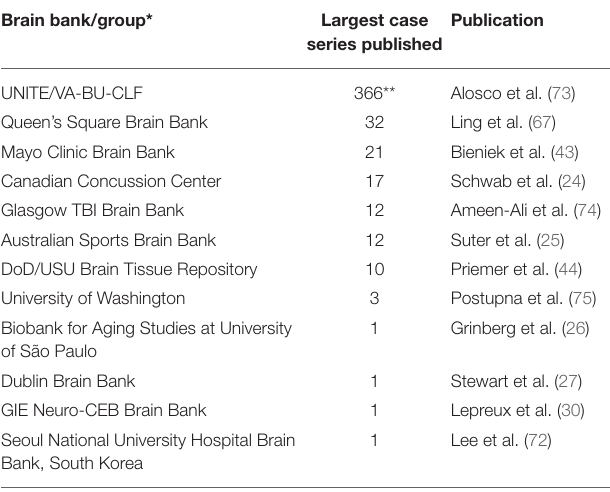
TABLE 3 | CTE cases diagnosed